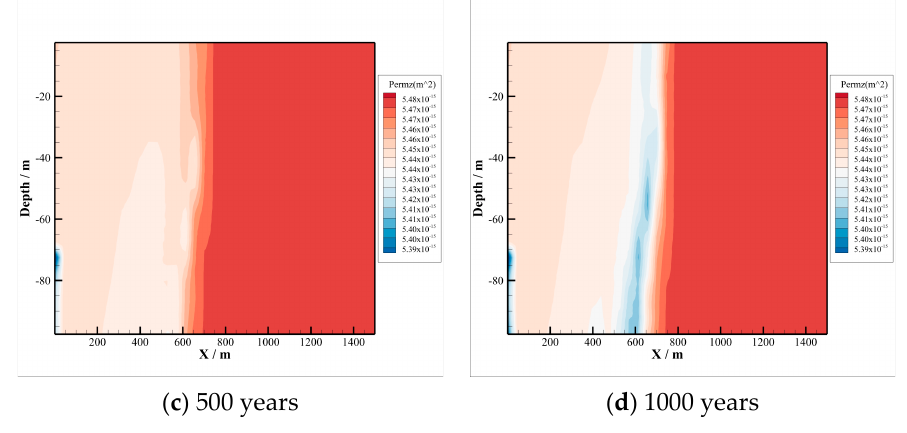
Figure 12. Variations in permeability.